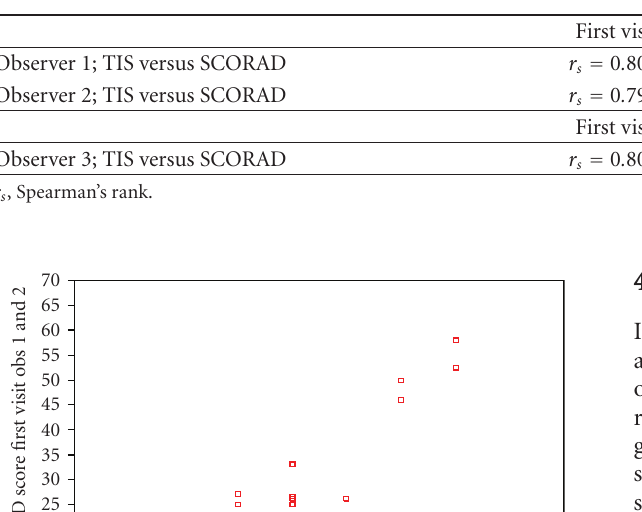
Table 4: Correlation between TIS and SCORAD.